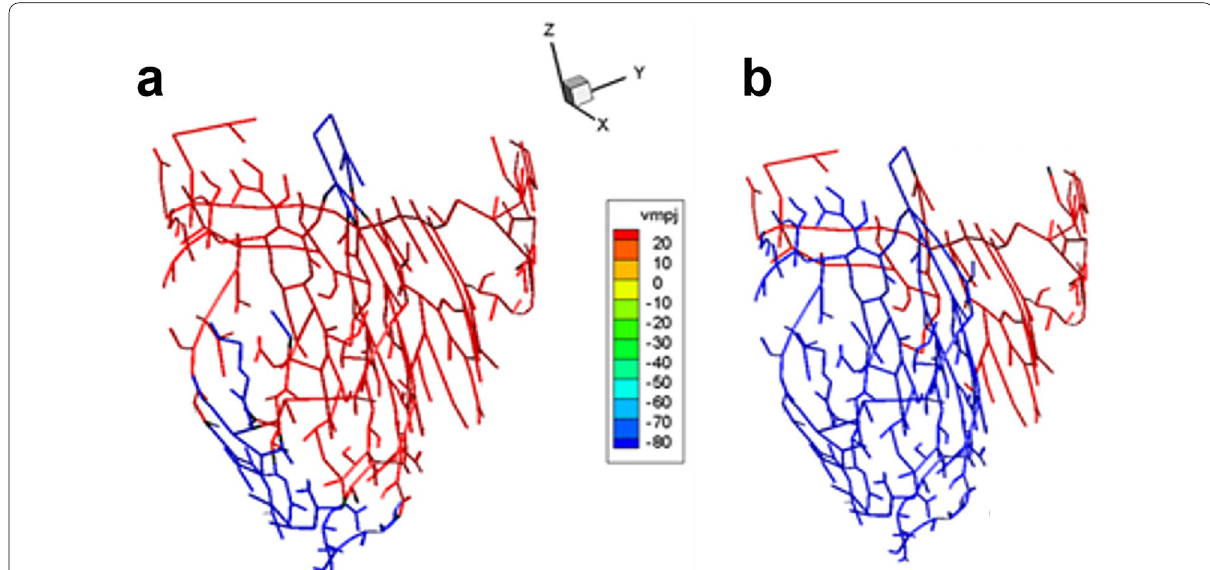
Fig. 3 Electric potentials in Purkinje fiber networks. Here, color indicates electric potentials. Red means electrically activated whereas blue means resting state. a. In normal ventricular conduction model, most parts of the ventricles activate almost simultaneously. b. In the LBBB model, most of the left part of the Purkinje fiber network remains electrically inactivated. LBBB left bundle branch =